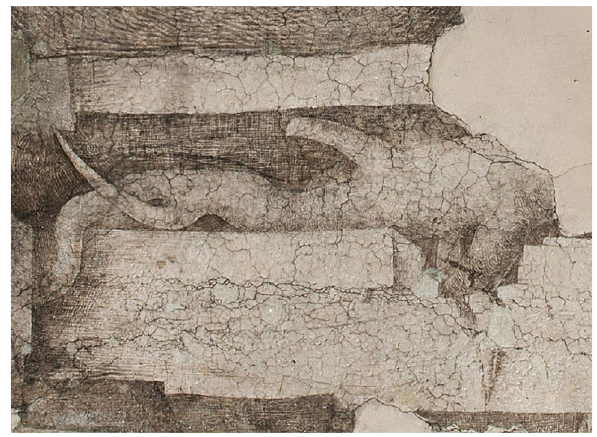
Figure 1. A detail of the “Monocromo” by Leonardo depicting a